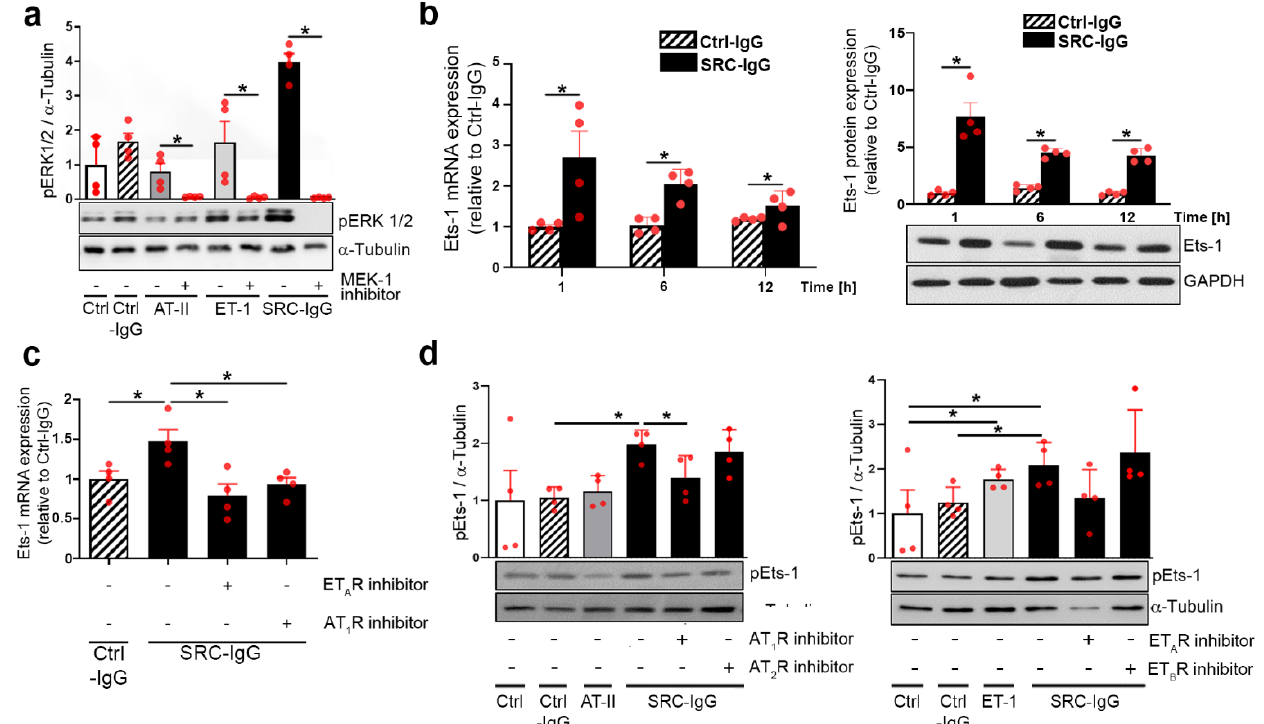
Figure 1. SRC-IgG activate Ets-1. Non-stimulated cells (Ctrl) were used as references when natural ligands were included, whereas Ctrl-IgG served as references when only IgG were used. ( a ) HMEC-1 were stimulated with AT-II, ET-1, Ctrl-IgG or SRC-IgG, with or without pre-incubation with MEK-1 inhibitor. ERK1/2 activation was measured as the pERK/ α -Tubulin ratios. ( b ) Ets-1 transcriptional ( left ) and translational levels ( right ) were measured over time after stimulation with Ctrl- or SRC-IgG. ( c ) Specificity was asserted by pre-treatment with an AT 1 R or ET A R inhibitor (Valsartan or Sitaxentan, respectively), before stimulation with Ctrl- or SRC-IgG. ( d ) ( left and right ) HMEC-1 were incubated with Ctrl-IgG, natural ligands or SRC-IgG with or without pre-incubation with respective receptor blockers. ( a – d ) n = 4; representative blots are shown. * p <